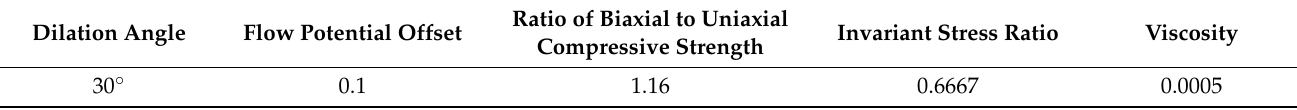
Table 2. CDP model parameters.